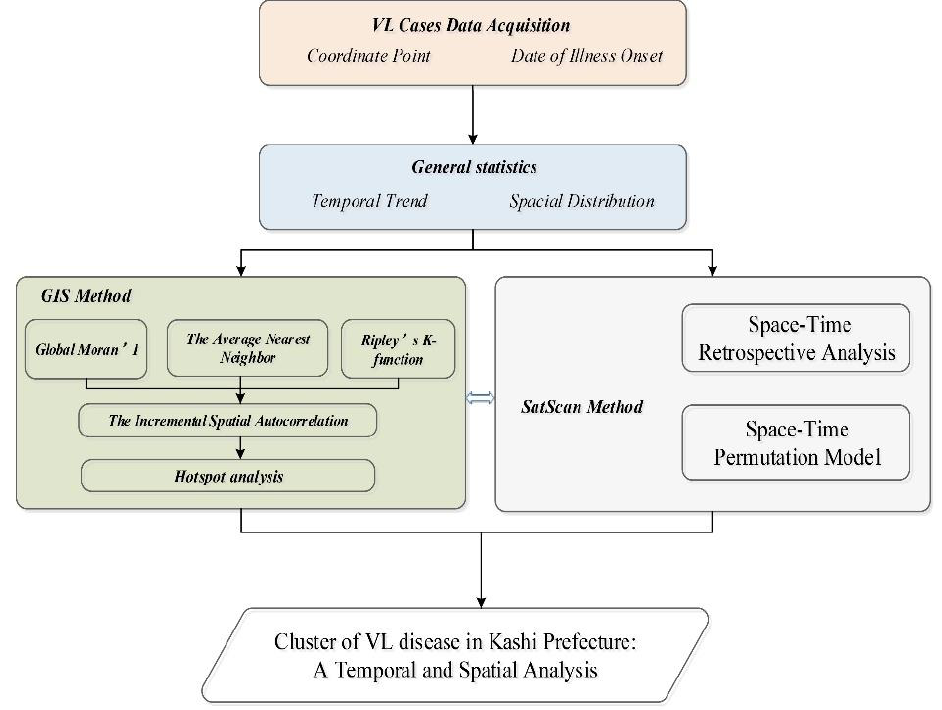
Figure 2. Research Technology Roadmap.